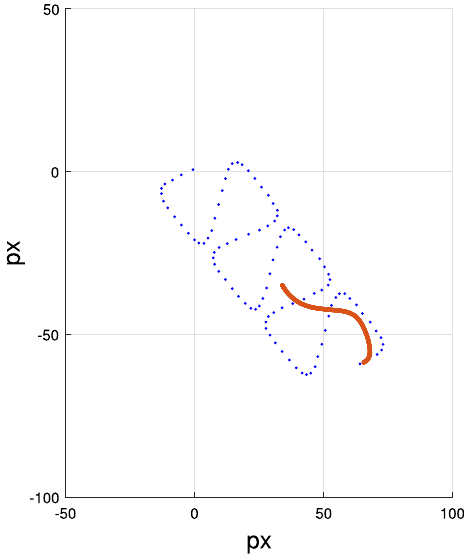
Figure 15. Example of sperm flagellum generation for linear mean swimming cell. (Orange) Simulated flagellum. (Blue) Track of linear mean swimming